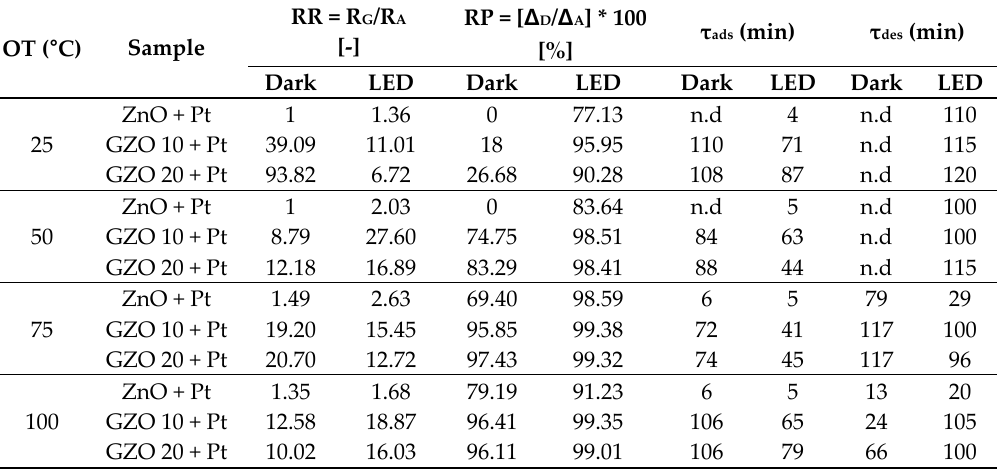
Table 1. Comparison of RR, RP, τ ads , and τ des to 400 ppb NO 2 in dark conditions and PB light ( λ = 430 nm) illumination at different OT (25–100